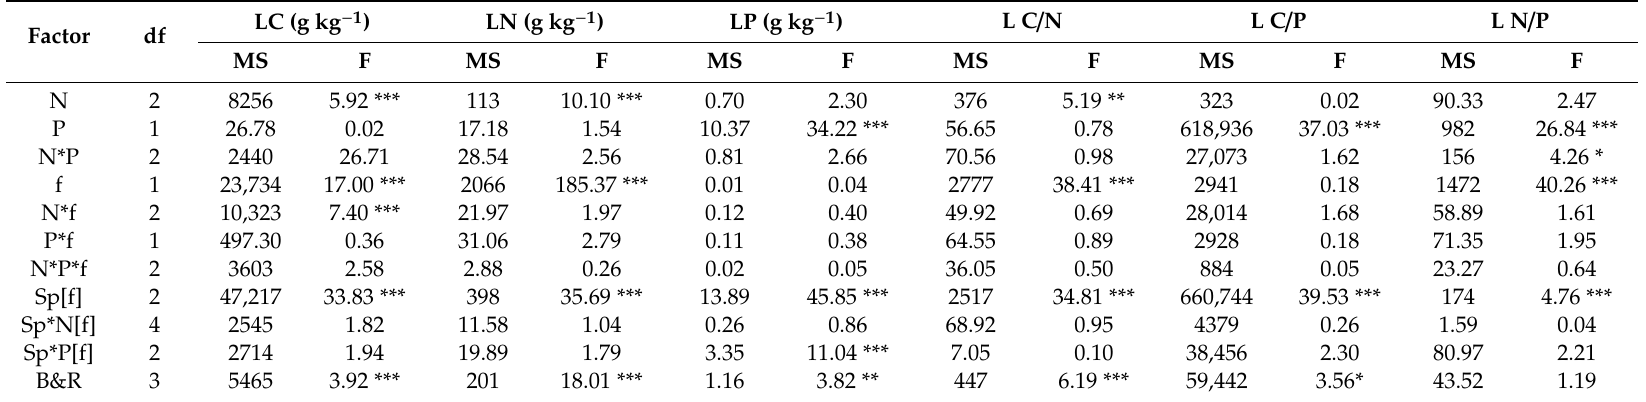
Table 2. ANOVAs on the e ff ects of nitrogen (N) and phosphorus (P) deposition, plant functional group (F), understory species (Sp; nested within plant functional group, f), and their interactions on litter (raw decomposed leaves) C, N, P, and C / N / P. B&R indicates randomized complete block design. The six indicators include the table. df is the degrees of freedom. *: p < 0.05; **: p < 0.01; ***: p <